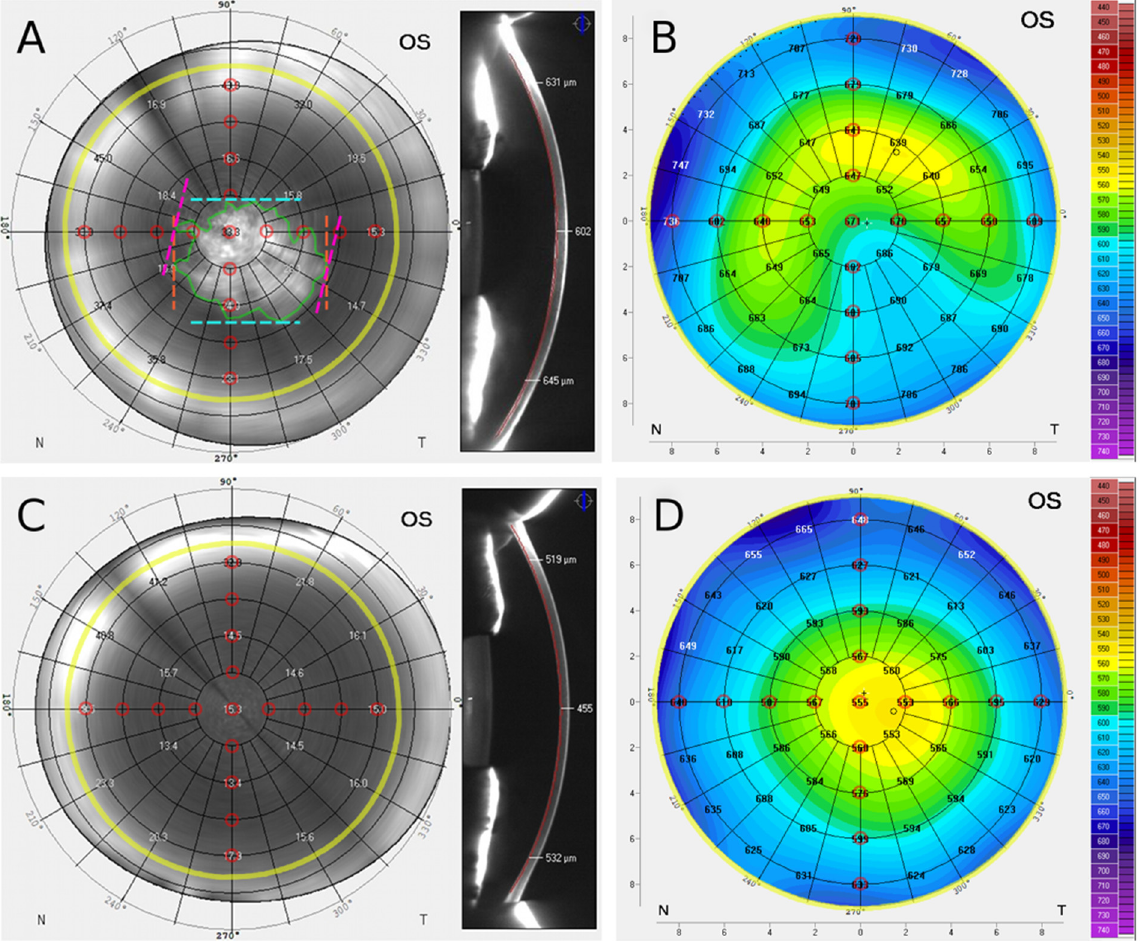
Figure 1. Scheimpflug backscatter and pachymetry in fibrillar layer (FL)-positive ( A , B ) and FL-negative ( C , D ) Fuchs endothelial corneal dystrophy (FECD) eyes: ( A ) En face Scheimpflug backscatter image of FL-positive FECD cornea: horizontal caliper diameter (orange), vertical caliper diameter (blue), maximum caliper diameter (pink) and FL area (green). FL shows inferotemporal localization. ( B ) Pachymetry map of FL-positive cornea: Increased corneal thickness inferotemporal. ( C ) En face Scheimpflug backscatter image of FL-negative cornea, ( D ) Pachymetry map of FL-negative cornea; superimposed grid marks concentric annuli around the corneal apex at 1 mm radial spacing (black) and at 4.5 mm radius (yellow). The study analyzed backscatter and pachymetry values along the vertical and horizontal axes (red circular marks).